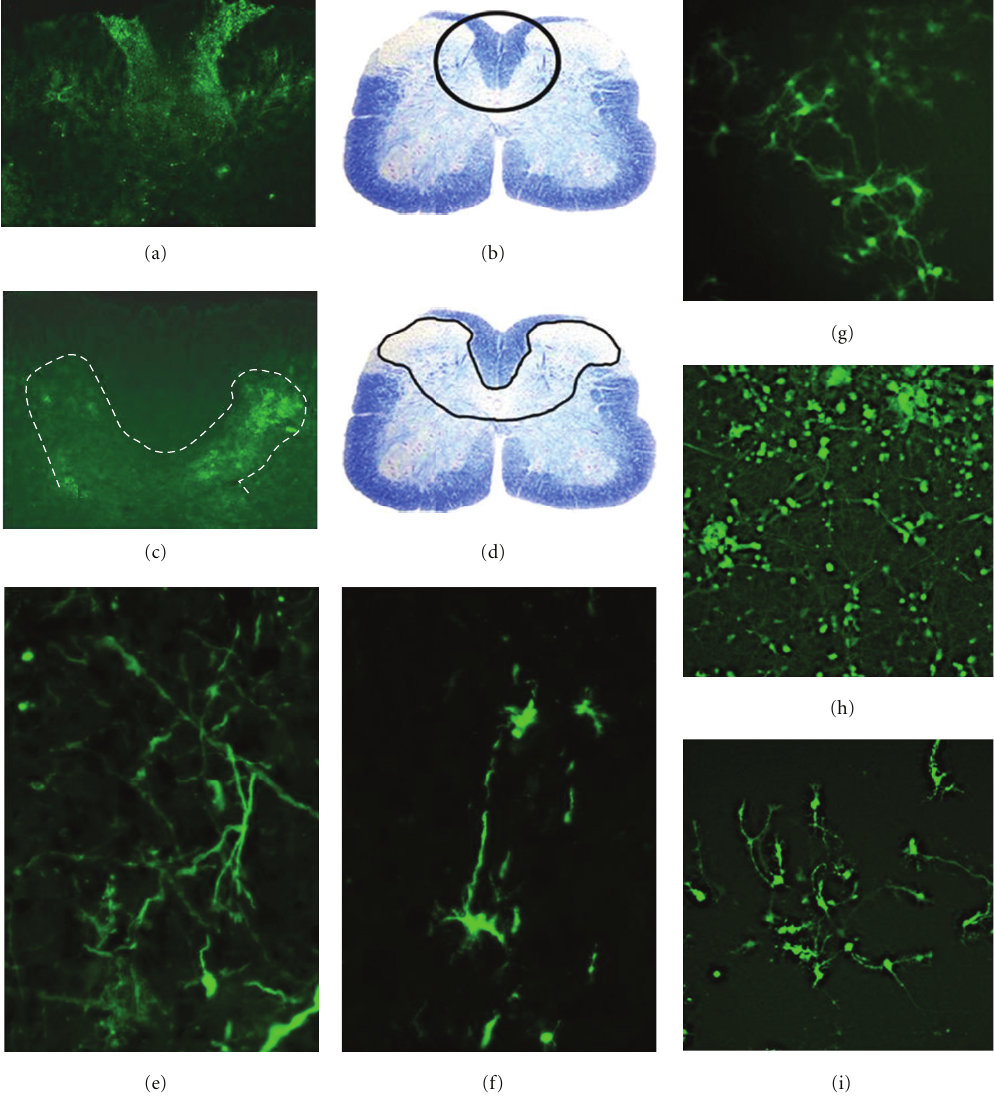
Figure 17: DM and NDM di ff er in their ability to translocate from gray matter to white matter during acute infection. DM- and NDM- infected mice were sacrificed at day 7 p.i.; brain and spinal cord tissues were harvested and processed for frozen sections. Cryostat sections were post fixed with 95% ice-cold ethanol for 20 minutes and observed by fluorescent microscopy for viral antigen (EGFP fluorescence). (a) In DM-infected spinal cord, viral antigen positive EGFP-expressing cells are present in both gray and white matters. (b) Area of EGFP positive cells from (a) is marked in a corresponding LFB-stained section. (c) In NDM-infected mice, EGFP positive cells with viral antigen are predominantly restricted to the gray matter. (d) Area of EGFP positive cells from (c) is marked in corresponding LFB-stained section. (e) Axonal distribution of the EGFP fluorescent viral antigen is evident in DM-infected brain. (f) NDM-infected neurons in the brain show considerably reduced axonal transport of viral antigen. (g–i) to further confirm the ability of DM and NDM to infect neurons and spread from neuron to neuron, 4-day-old primary hippocampal neuronal cultures were infected with DM and NDM at MOI of 2. Representative fields containing an equivalent density of cells are shown in each image. (g) At 24 hours p.i. DM infect a small percentage of the neurons in culture. (h) By 72 hours p.i. DM-infected neurons were observed to spread from one neuron to the next, as nearly all cells in the culture contained viral antigen despite initial infection of only a small percentage of cells. (i) NDM-infected neurons, on the other hand, demonstrate limited axonal transport e ffi ciency at 72 hours p.i., with only a small number of cells containing a bright concentrated signal that is retained after primary infection. (adapted from the work of